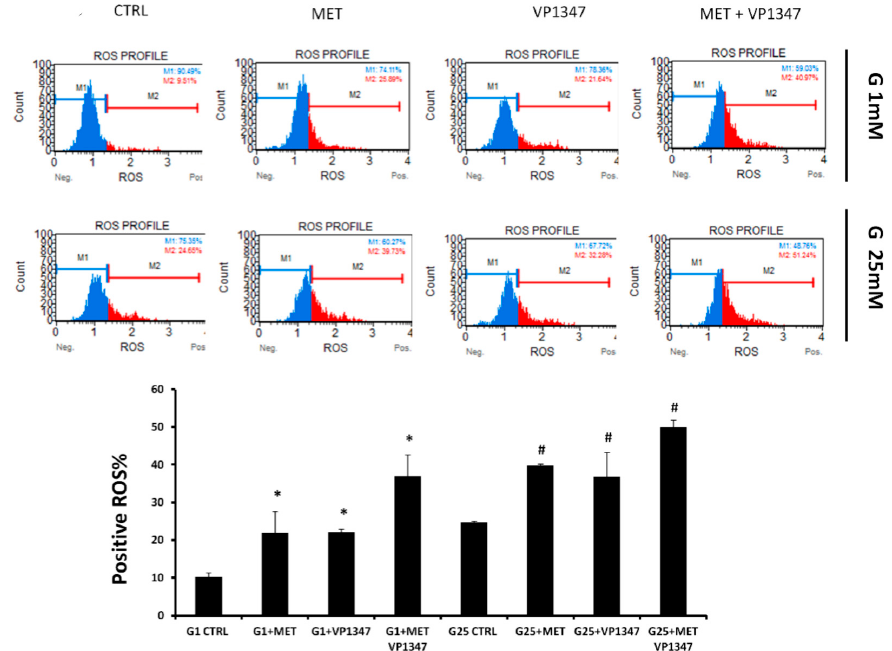
Figure 6. Effect of Metformin and HO-1 activity inhibitor VP1347 on DU145 cells ROS production. Cells were incubated with 1 mM glucose (G1) or 25 mM glucose (G25) in the presence and absence of 10 mM metformin (MET) and 10 µM VP1347 for 6 h. The quantitative measurement of cells undergoing oxidative stress was evaluated by cytometry, using the Muse Oxidative Stress Kit. The graph showed the positive ROS percentage in the different groups. * p < 0.05 vs. G1 CTRL, # p < 0.05 vs. G25 CTRL.